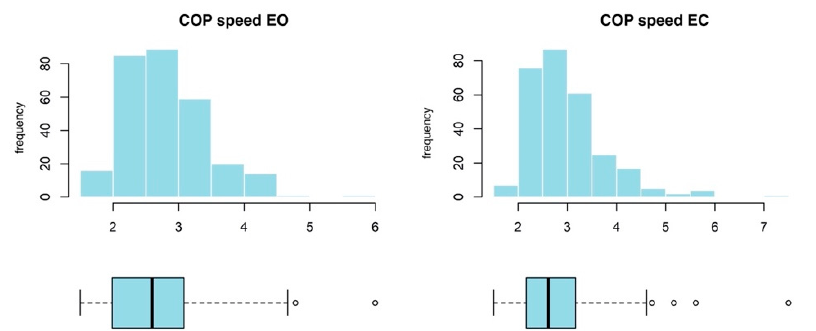
Figure 9. Box plots and histograms for the two-dimensional COP sway velocity variable. The graphs were constructed from all the data gathered from both groups. COP—center of pressure; EO—eyes open; EC—eyes closed.